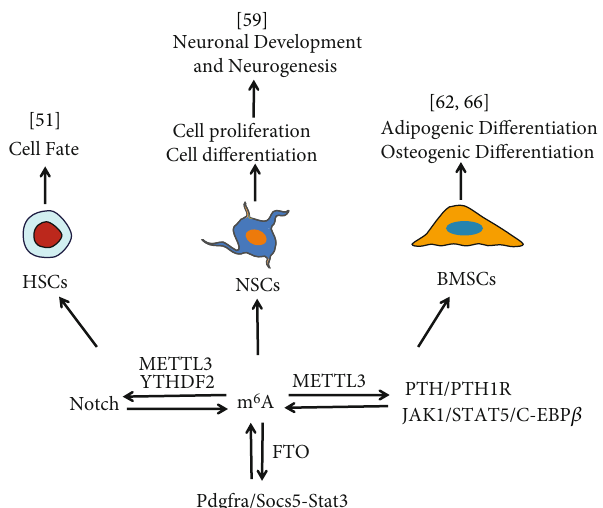
Figure 2: m 6 A RNA methylation interacts with multiple signaling pathways to regulate the proliferation and di ff erentiation of di ff erent